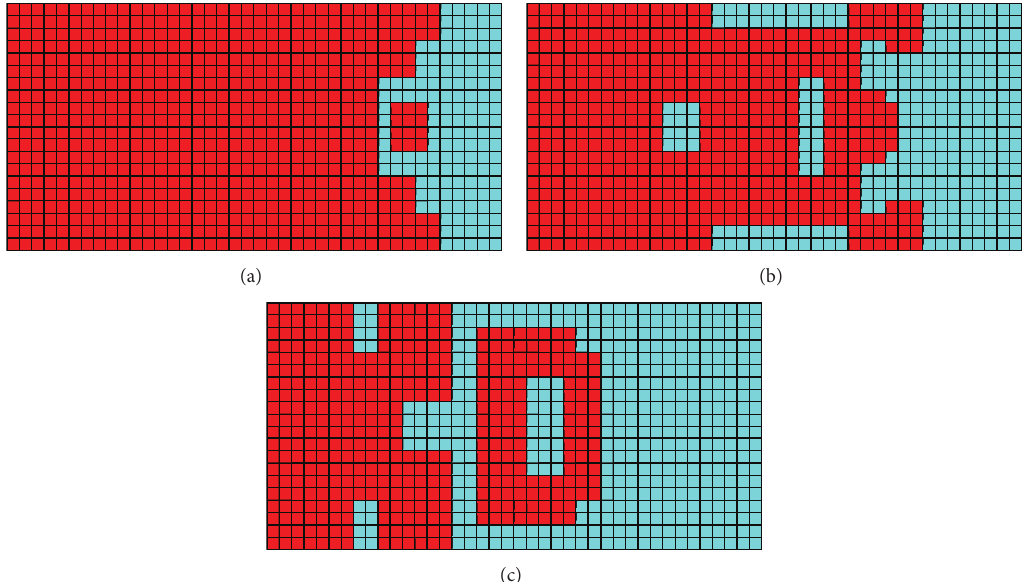
Figure 5: Topology evolving process using improved sensitivity analysis. (a) Iteration 7 (rejection ratio 17.5%). (b) Iteration 14 (rejection ratio 35%). (c) Iteration 20 (rejection ratio